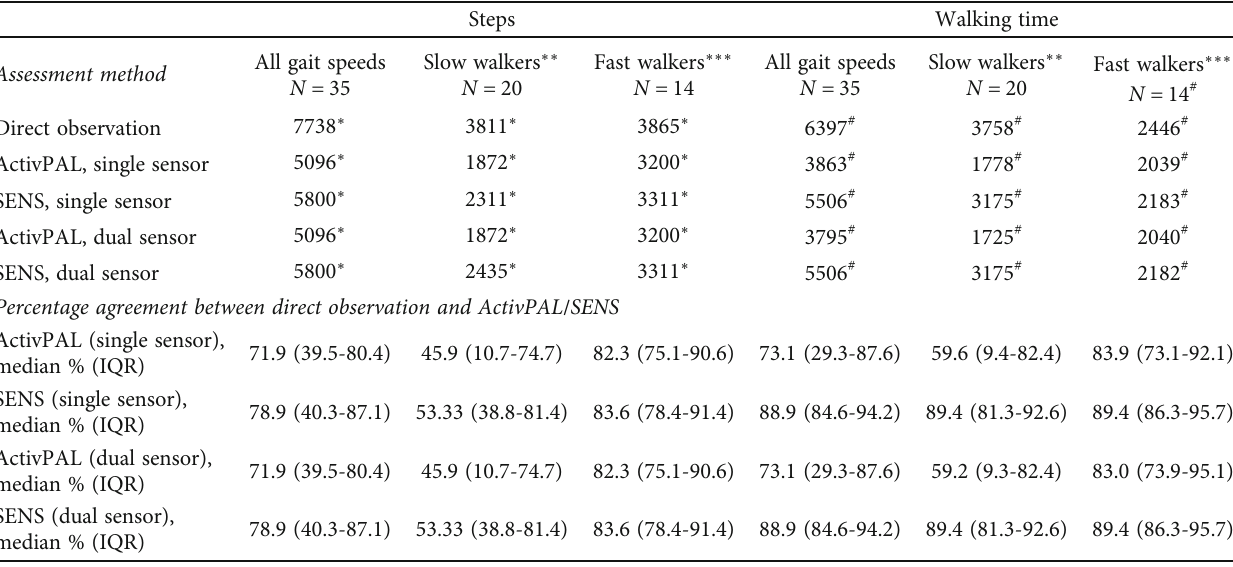
Table 3: Agreement between steps and walking measured by direct observations and by ActivPAL3 ™ and SENS motion® used as both single- and dual-sensor